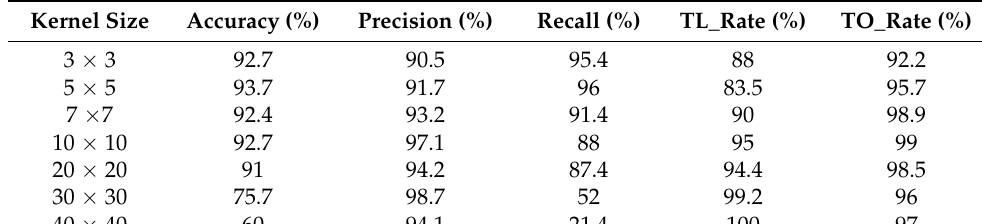
Table 5. Defect inspection results according to kernel size of 1st layer.